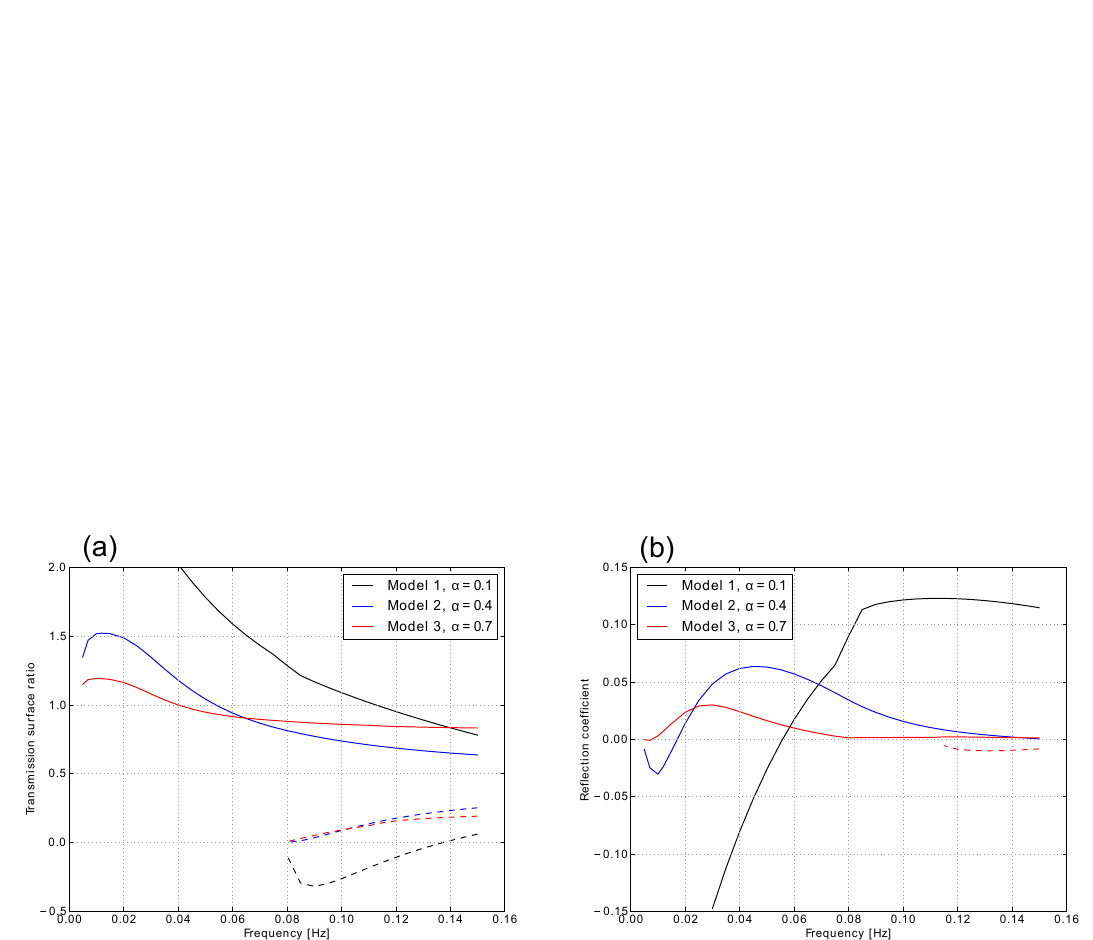
Figure B3. Love wave surface transmission ratios (a) and reflection coefficients (b) for an incident fundamental mode propagating in the forward direction through three varieties of Alsop66’s M-discontinuity step model. The model varieties are indicated by the geometrical parameter α (see Fig. 13 of Alsop66 for its definition). Values obtained with SWRT (solid lines for the fundamental mode, dashed lines for the first overtone) are nearly identical to the original results of Alsop66 (its Figs. 14 and 15). The only apparent discrepancy is in the sign of the transmitted first higher mode for the α = 0 . 1 model, which was wrongly plotted by